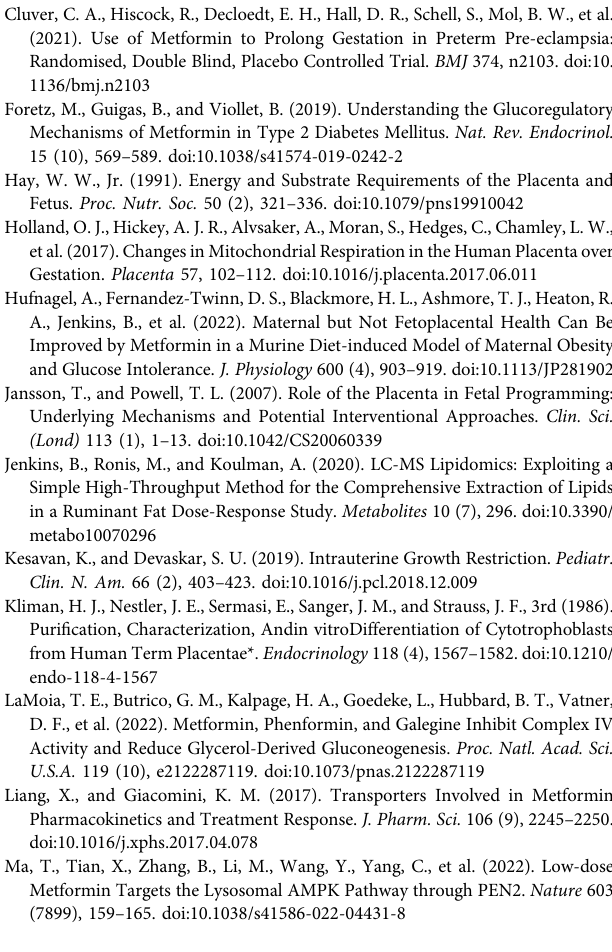
Supplementary Figure S2 | Mitochondrial biogenesis markers in trophoblasts: with metformin (0.01mM or 0.1mM) versus control. (A) Mitochondrial DNA copy number per cell ( n = 17 per group); (B) Relative mRNA level of nuclear receptor factor-1 ( NRF1) ( n = 20 per group); (C) Relative mRNA level of nuclear receptor factor-2 ( NRF2) ( n = 20 per group); (D) Relative mRNA level of Mitochondrial transcription factor A ( TFAM) ( n = 20 per group); (E) Relative mRNA level of Peroxisome proliferator-activated receptor-gamma coactivator (PGC1 α ) ( n = 20 per group). Individual data points each represent a single trophoblast sample with points more than 1.5x IQR highlighted with larger